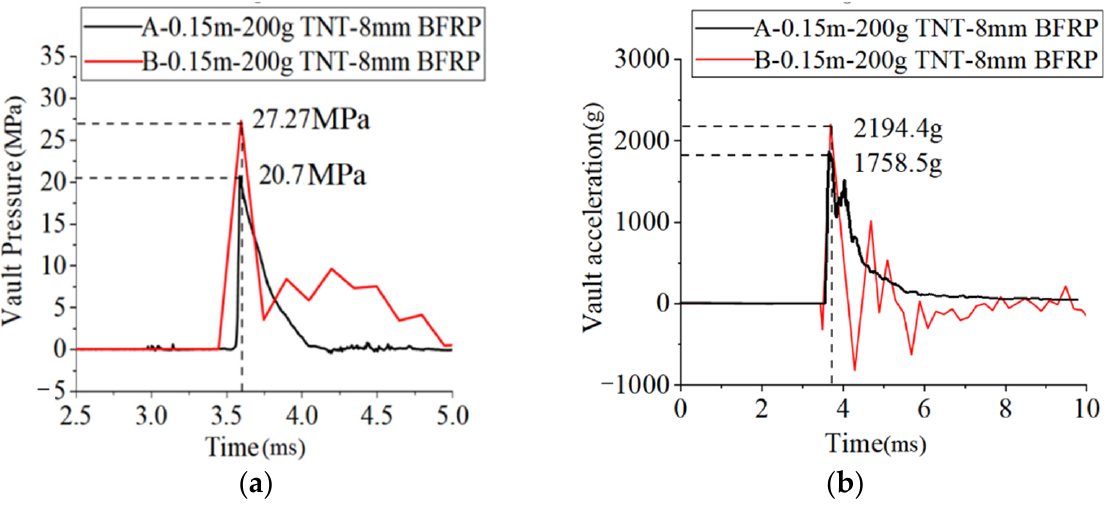
Figure 7. Comparison of the experimental and simulated time history curves of ( a ) the dynamic pressure, and ( b ) the acceleration at the vault. (Curve A: experimental result, curve B: simulation result).